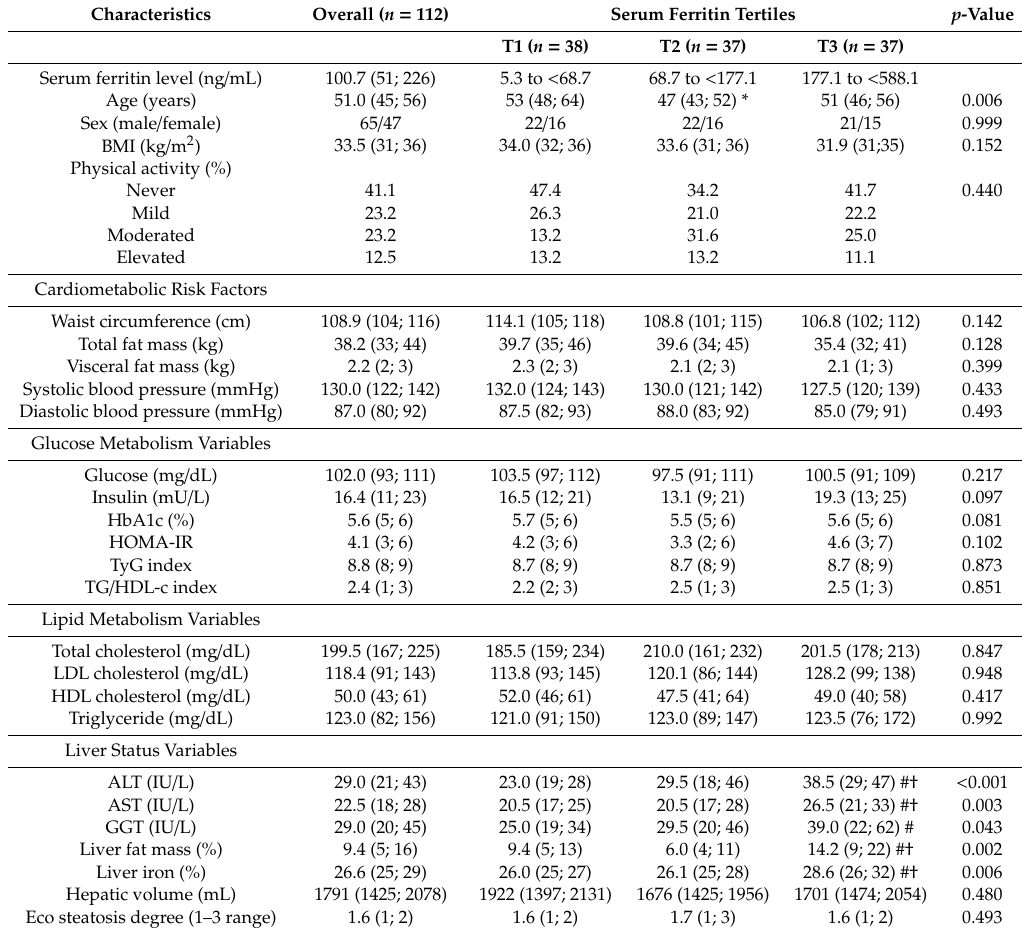
Table 1. Baseline characteristics of participants according to sex-specific serum ferritin